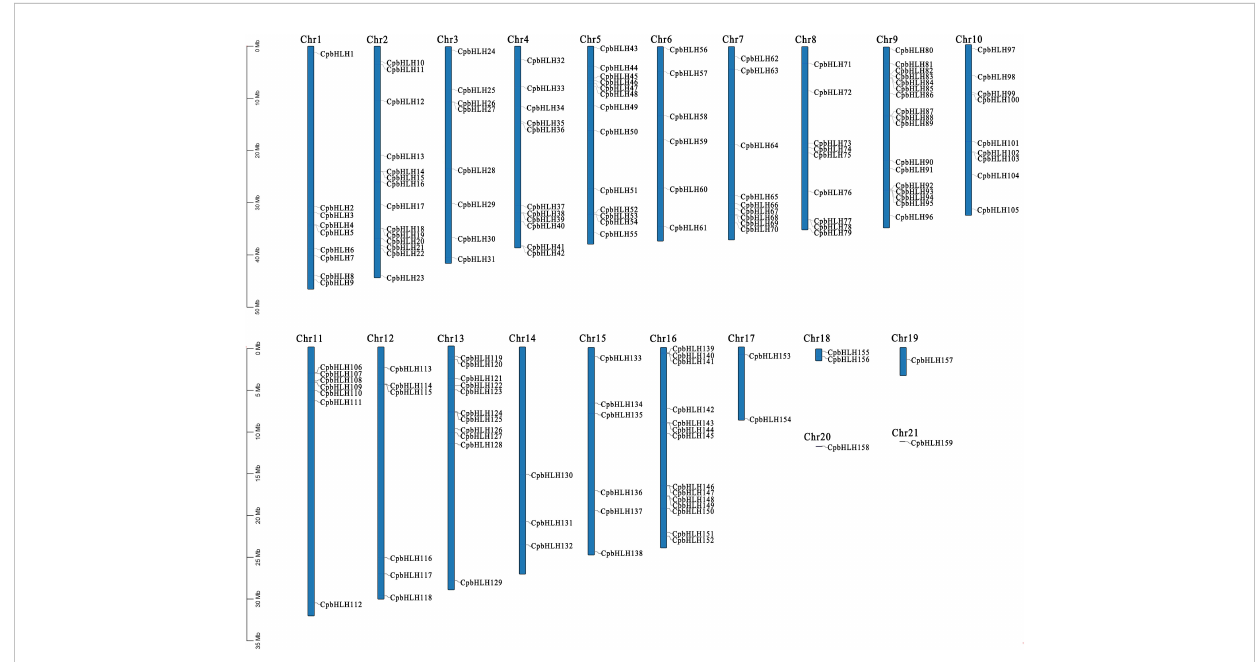
FIGURE 2 Chromosomal locations of the CpbHLH genes. The 159 CpbHLH genes were distributed on 21 pseudo-chromosomes of C. paliurus based on their physical